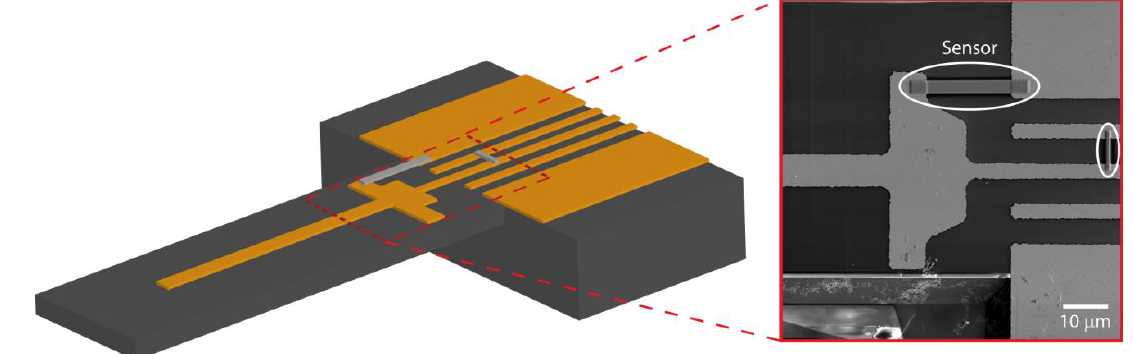
Figure 2. 3D-schematics of the cantilever chip used for strain sensor measurements. The cantilever dimensions are length: 500  m, width: 70  m, height: 10  m. The strain sensors are deposited between the Au/Cr-contacts across the bending edge. The inset displays a SEM image of the substrate for two Pt-deposits, one serving as the strain sensor and one for